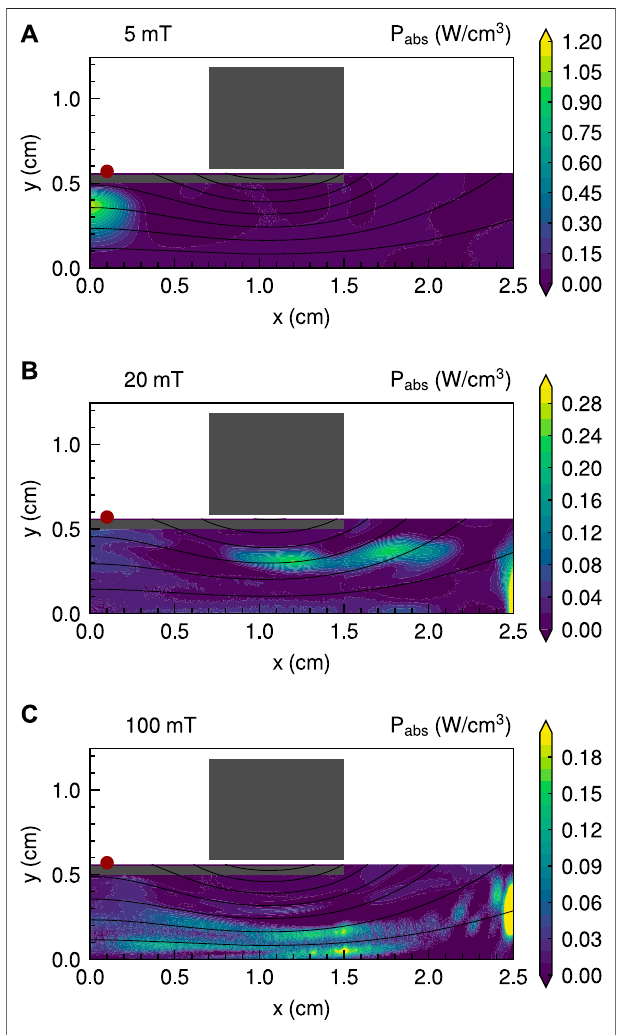
FIGURE 7 | x - y pro fi les of the power absorption P abs for the three magnetic fi eld strengths of (A) 5, (B) 20, and (C) 100 mT. Solid black lines show magnetic fi eld lines.